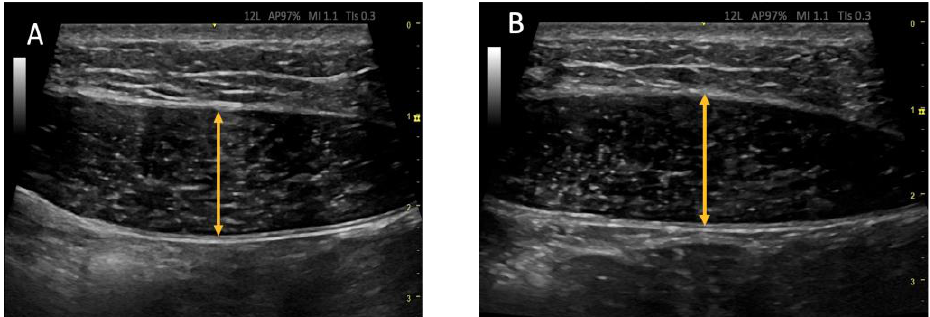
Figure 2. Ultrasound images of the lateral abdominal wall musculature showing the 3 muscle lay- ers from top to bottom: External Oblique (EO), Internal Oblique (IO), and the deepest, Transverse Abdomen (TrA); separated from each other by intermuscular connective tissue (hyperechoic lines). ( A ) Image at rest. ( B ) An image taken during muscle activity showing a change in muscle thickness. Measurements are always taken at the same point, 2 cm (the orange mark) from the insertion of the TrA in the RA.